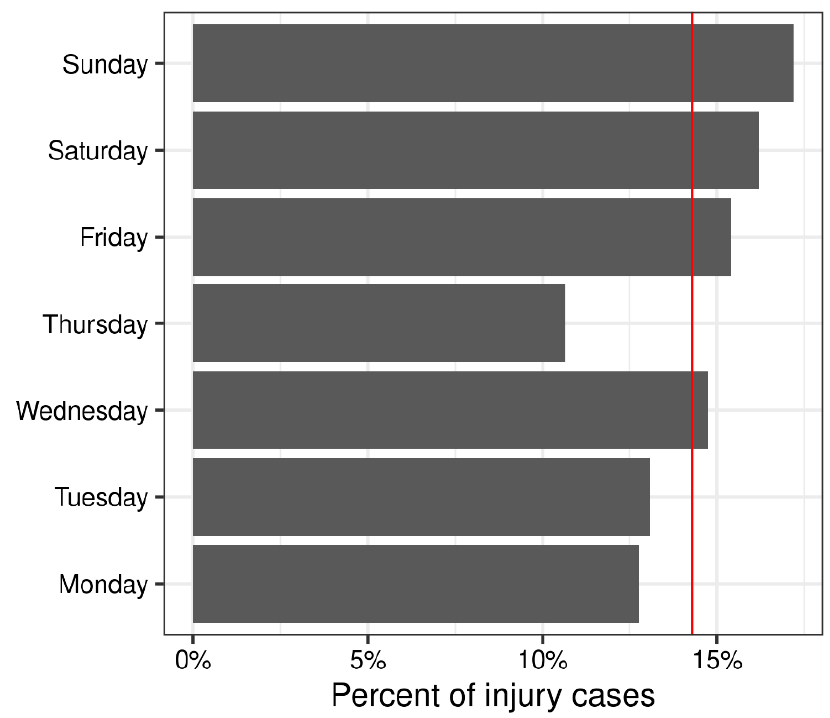
Figure 2. Percentage of total injury counts per day of the week. The red line shows the expected percentage assuming no difference by day of the week. Aggregated over the 1 March 2015–28 February 2021 time period. Injuries were more likely on weekends compared to weekdays ( p =